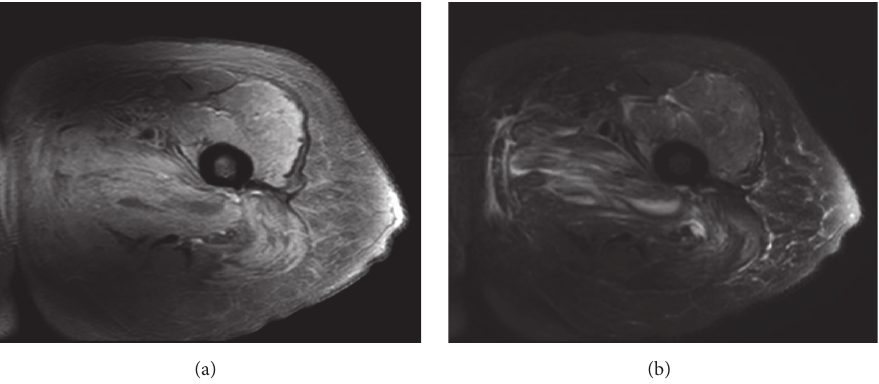
Figure 1: (a) MRI axial T1 with gadolinium, (b) axial T2 without gadolinium showed collection sized 2.9 × 3 cm with intramuscular edema.